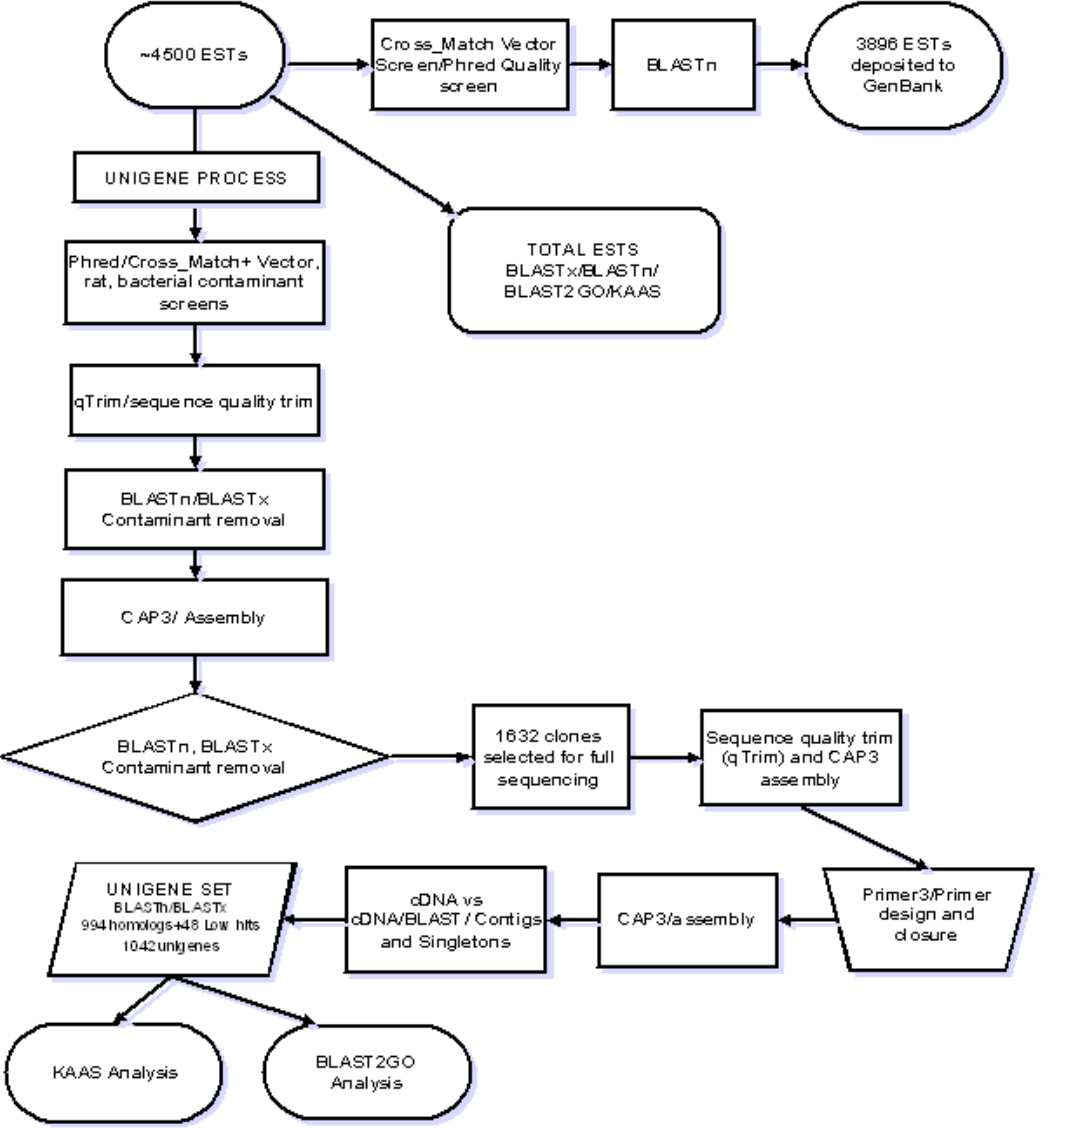
Figure 1. EST Analysis and Unigene Process. The raw sequence reads of the Expressed Sequence Tags were first purged of poor quality sequence (arrows to right of starting point). The resulting 3,896 reads were deposited to NHLBI GenBank and further analyzed for similarities to genes and gene products in the UNI-PROT_TREMBL databases using BLASTn and BLASTx and putative function with BLAST2GO and KASS. The raw reads were then processed using an iterative scheme to form the unigene set starting with a primary screen to purge sequences originating from the cloning vector, rat host and bacteria, followed by a trimming of the sequence ends to reduce poor quality sequence, using an in house program (qTrim). After trimming, the sequences were again purged of contaminants using BLASTn and BLASTx, then assembled using the CAP3 assembly program. After another round of contaminant removal, 1,632 cDNA clones representing putative unique genes were selected for full sequencing. These sequences were then subjected to the same qTrim program, then assembled by CAP3. The primer design program, Primer3 was used to design primers to close gaps in those clone sequence that did not represent full sequences. After another round of assembly, the cDNA sequences were compared to one another for sequence identity using BLASTn, to identify any redundant gene sequences. This resulted in a set of 1042 unique sequences (both contigs and singletons) of which 994 had significant similarities (E # 10 2 6 ) to genes within the UNI-PROT_TREMBL and 48 did not have significant similarities to existing genes (E $ 10 2 6 ). The unigene set was then analyzed for putative functions by BLAST2GO and